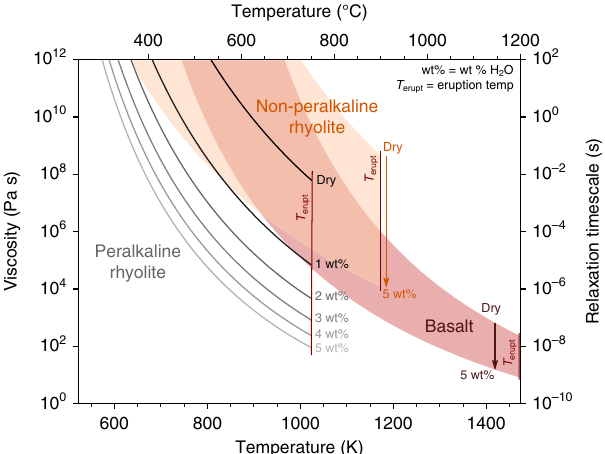
Fig. 6 Viscosity-temperature relationship for peralkaline rhyolite melt with varying water concentration. Pantellerites typically contain between 2.5 and 5 wt% H 2 O prior to eruptive degassing 27,28 . The melt viscosity for pantellerites is calculated using the model of ref. 3 . For comparison, the viscosity-temperature relationship calculated by the VFT equation 23 is shown for a typical, non-peralkaline (in this case peraluminous), rhyolitic melt (Rhyolite Glass Mountain – 1 standard) and basaltic melt (Basalt Hawaii Volcanic Observatory – 1 standard). Note that at eruption temperature, hydrous Aluto peralkaline rhyolites have a similar melt viscosity to basalts, and possess exceptionally low glass transition temperatures (temperature at which viscosity = 10 12 Pa